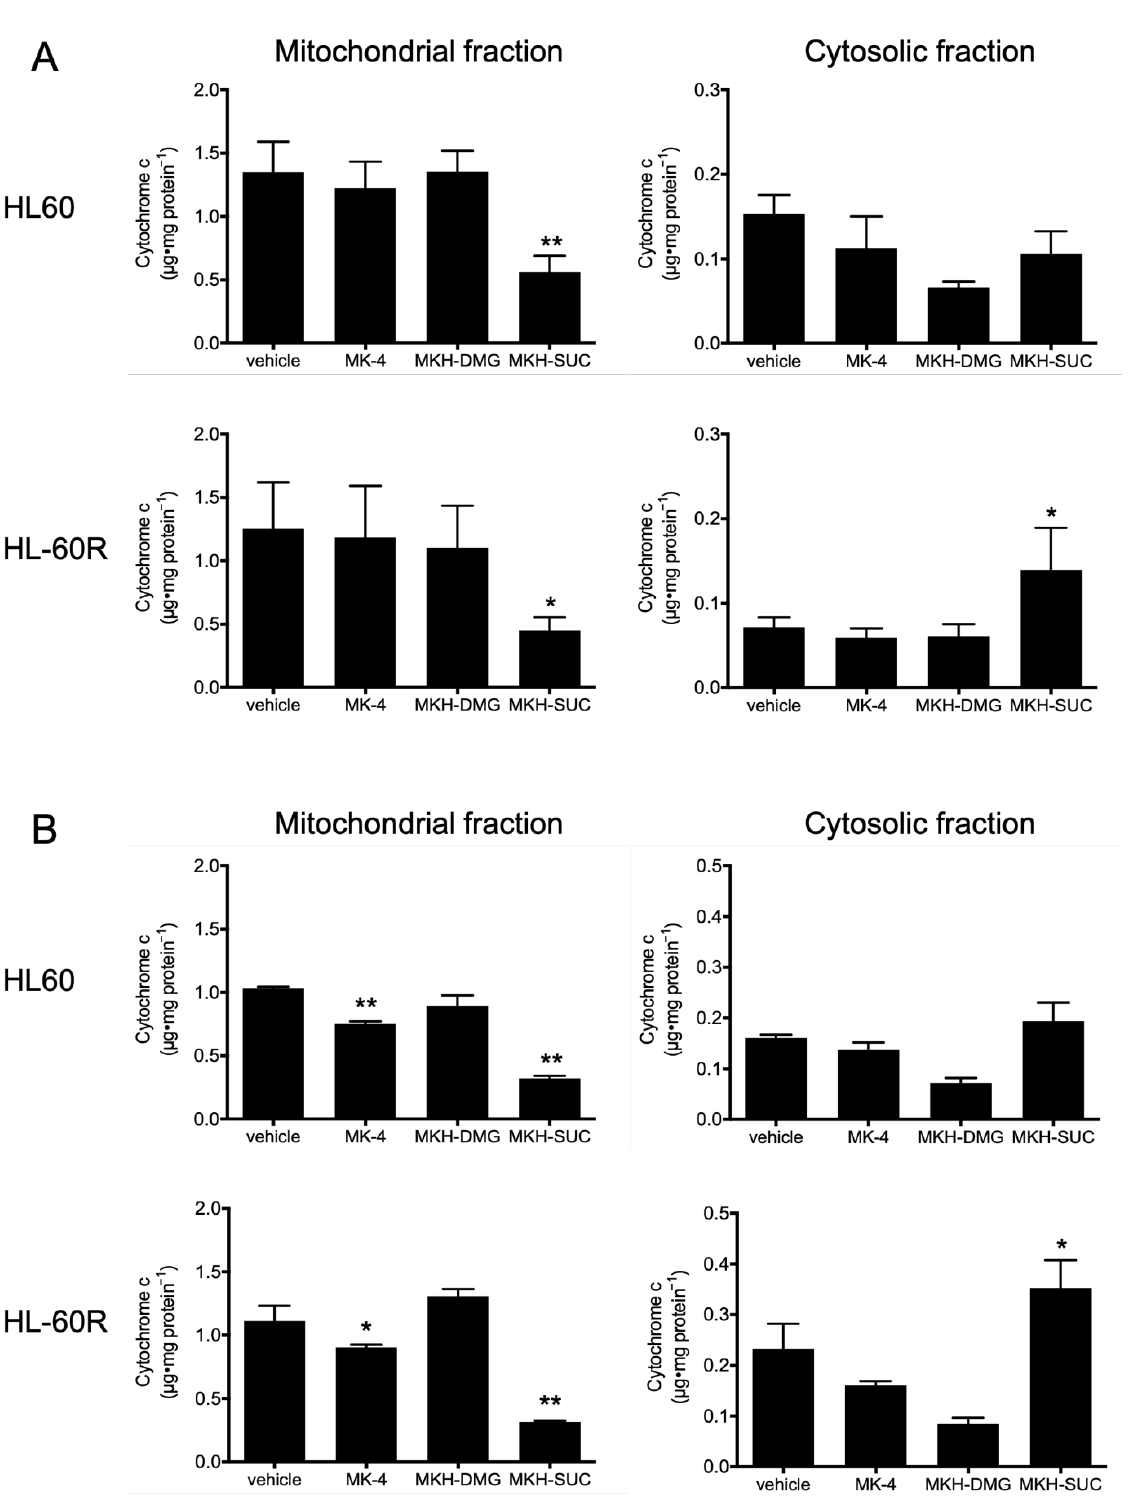
Figure 8. Release of cytochrome c in HL60 and HL-60R cells treated with MK-4 and MKH derivatives. HL60 and HL-60R cells treated with the test drugs at 10 µM for 48 h ( A ) or 72 h ( B ). The cytochrome c level in the mitochondrial or cytosolic fractions was determined using ELISA. Data are shown as mean ± SD from at least 3 replicates. * p < 0.05, ** p < 0.01 vs. vehicle by Dunnett’s test.